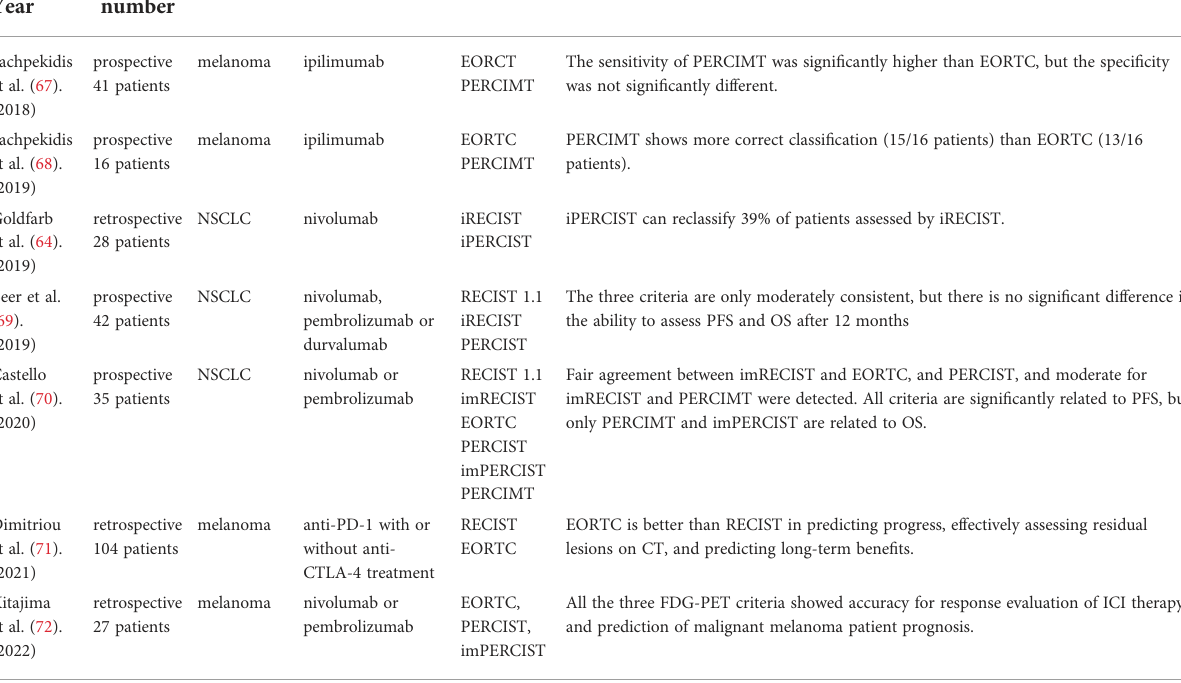
TABLE 3 Comparative studies on evaluation criteria of immunotherapy